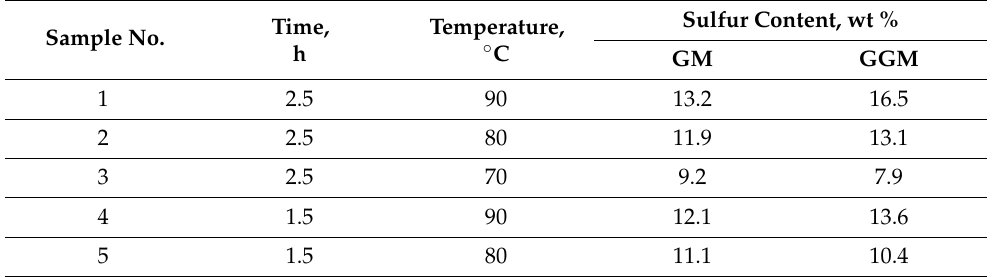
Table 1. Effect of the GM and GGM sulfation conditions on the sulfur content in the reaction products. Sample